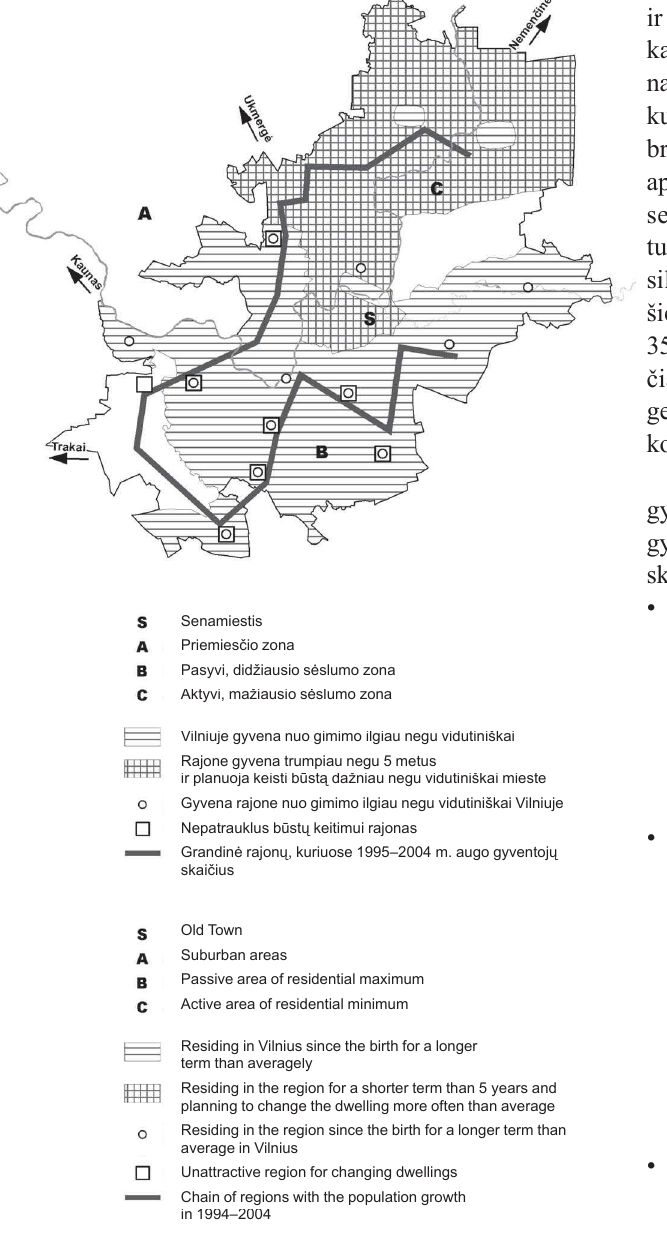
Fig 1 . Localization mobility of residents (Vilnius, 2005)